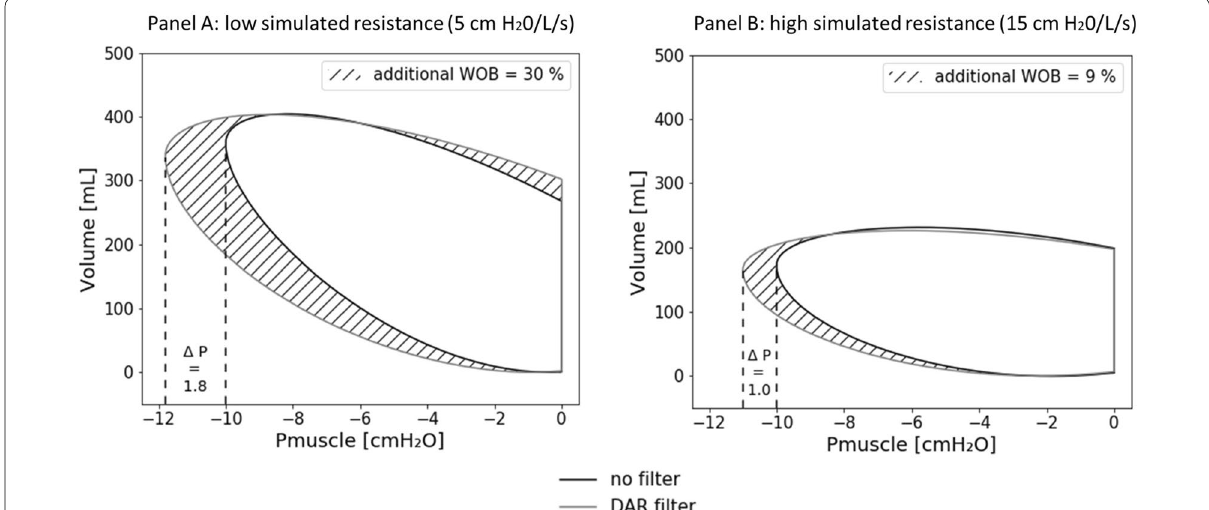
Fig. 2 Bench study. The figure represents dynamic simulated muscle pressure (Pmus)–volume loops recorded with and without the addition of the DAR filter (see text). The change of tidal volume between configurations with and without filter was calculated. The pressure–volume loop with filter was obtained by increasing simulated patient effort to maintain Vt constant (same Vt than in the without filter configuration). The patient work of breathing (WOB patient) was defined as the trapezoidal numerical integration of the pressure–volume curve, which corresponds to the area under the curve. The shaded area represents the relative change in patient’s WOB induced by the filter to keep the Vt constant. ∆P represents the maximum change in muscle pressure between the two configurations. a Dynamic Pmus–volume loops obtained using the Boussignac valve with and without additional filter in the following conditions: moderate simulated effort (10 cm H 2 O), low simulated respiratory system resistance (5 cm H 2 O/L/s) and CPAP set at 6 cm H 2 O. b Dynamic Pmus–volume loops obtained using the Boussignac valve with and without additional filter in the following conditions: moderate simulated effort (10 cm